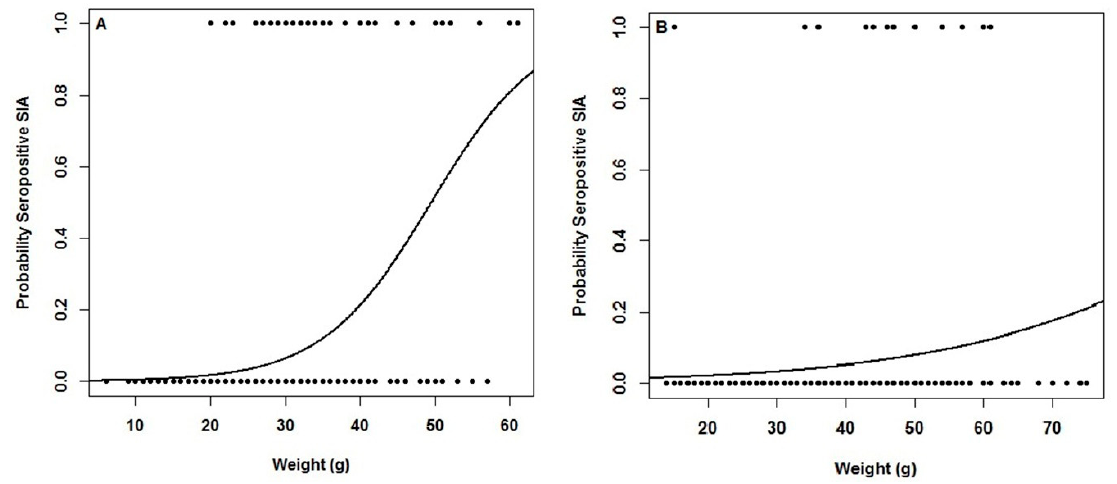
Figure 3. Logistic regression including seropositives for anti-ANDV antibodies versus weight of each capture specimen in sites associated with human hantavirus cases in Chile for (A) O. longicaudatus , and (B) A. hirta .